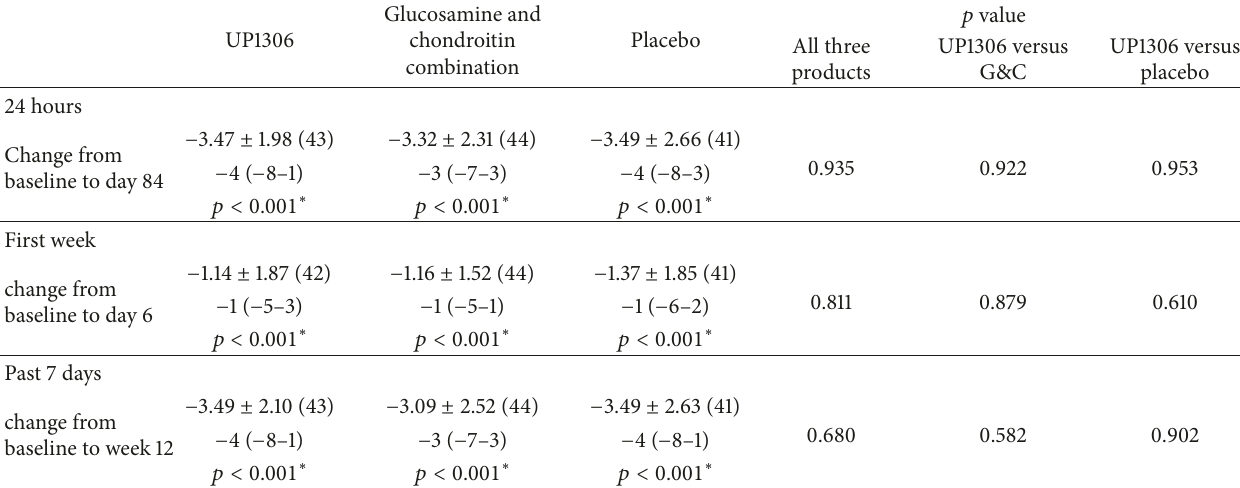
Table 2: VAS-discomfort